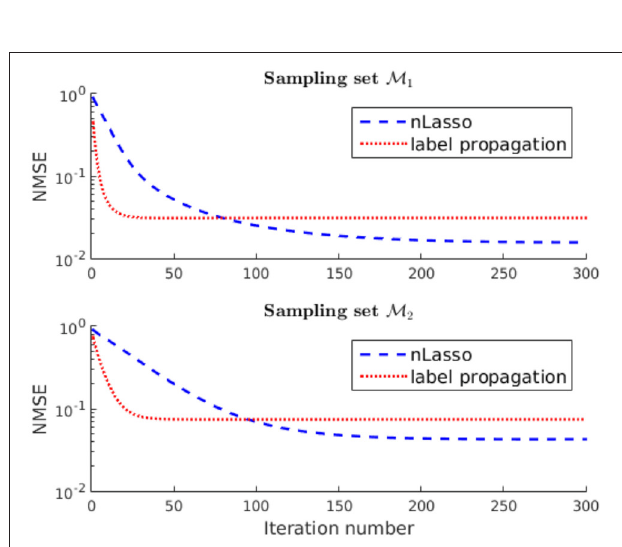
FIGURE 8 | Evolution of the NMSE achieved by increasing number of nLasso-ADMM iterations and LP iterations. Both algorithms are fed with the same signal samples obtained either over sampling set M 1 or M 2 ,